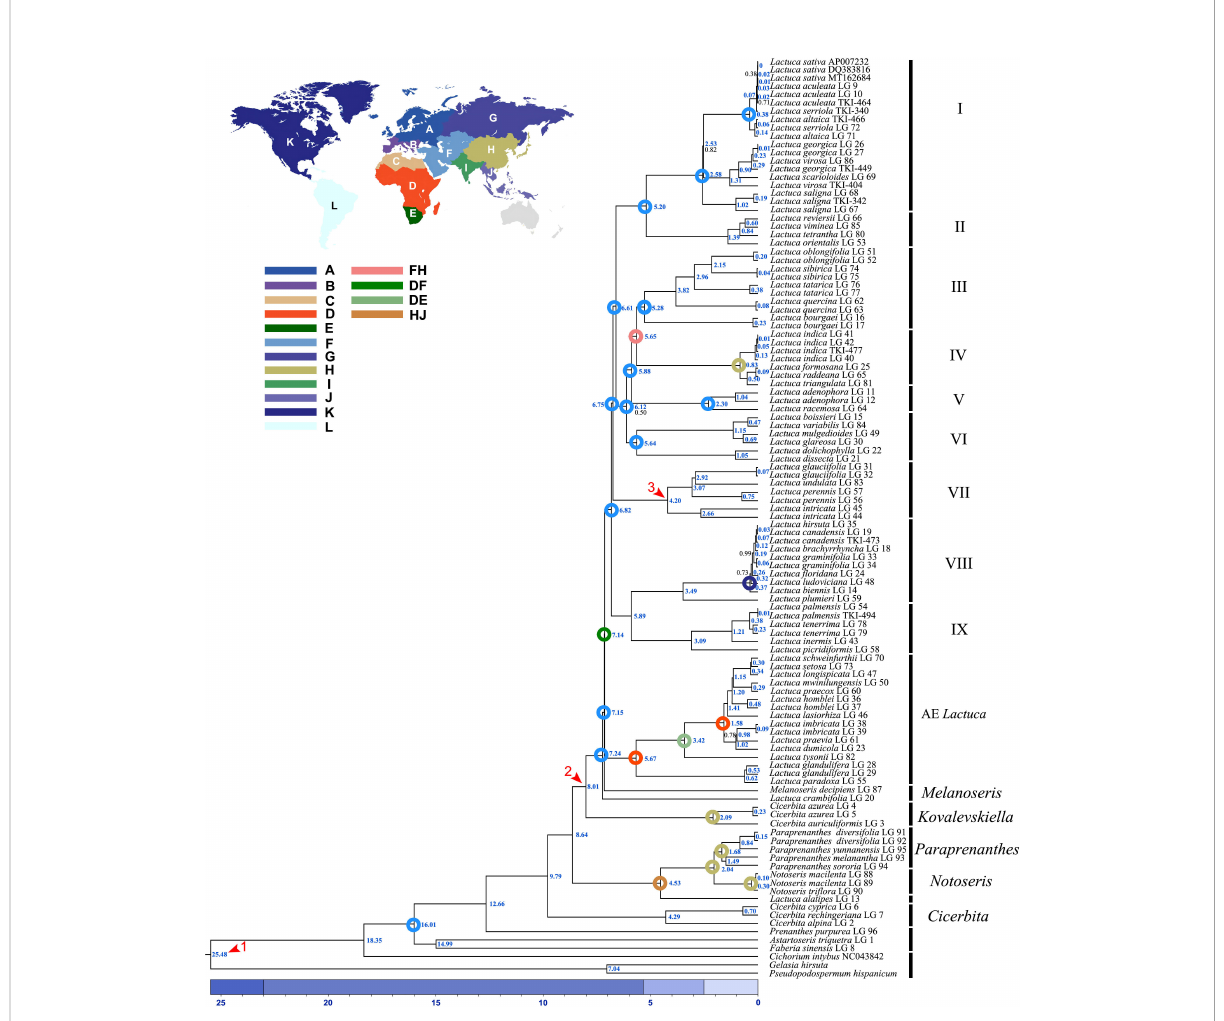
FIGURE 5 Dated phylogram of Lactuca and related genera based on complete plastomes. The red arrows are the calibration points of divergence time. The blue numbers indicate the median node age of divergence, and the black numbers indicate the support of Bayesian posterior probability (PP = 1 is not displayed; colored circles displayed on nodes are ancestral ranges with probability = 1, except the one of Lactuca lineages). Geographical areas are indicated with different colors: (A) N+Central+E Europe, (B) SW+SE Europe, (C) N Africa+Macaronesia, (D) Tropical Africa, (E) S Africa, (F) Asia- Temperate W, (G) Siberia+Russian Far East, (H) Asia-Temperate E, (I) Indian Subcontinent, (J) Asia-Tropical E, (K) N America, (L) S